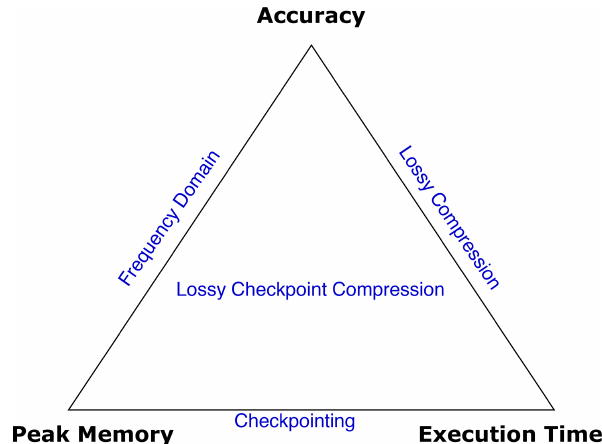
Figure 3. Schematic of the three-way tradeoff presented in this pa- per. With the use of checkpointing, it was possible to trade off mem- ory and execution time (the horizontal line). With the use of com- pression alone, it was possible to trade off memory and accuracy. The combined approach presented in this work provides a novel three-way